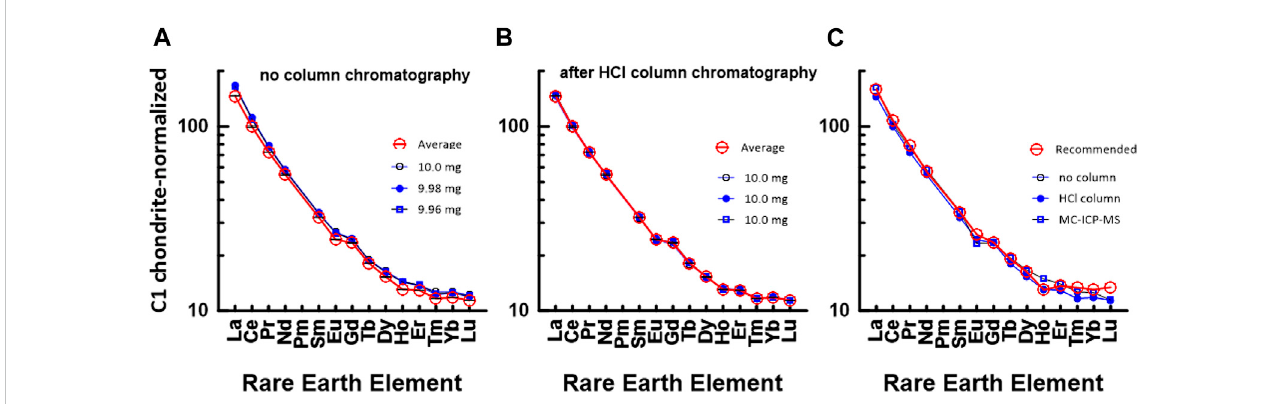
FIGURE 4 C1 chondrite (McDonough and Sun, 1995)-normalized REE patterns of JB1b: (A) measured by conventional ICP-MS method without HCl column chromatography inthis study and (B) measuredby conventional ICP-MS method after HCl column chromatography inthisstudy. The numbers in (A) indicate the gravity weight of sample. (C) based on the data measured by MC-ICP-MS in this study, recommended value by GSJ, and average value of (a) and